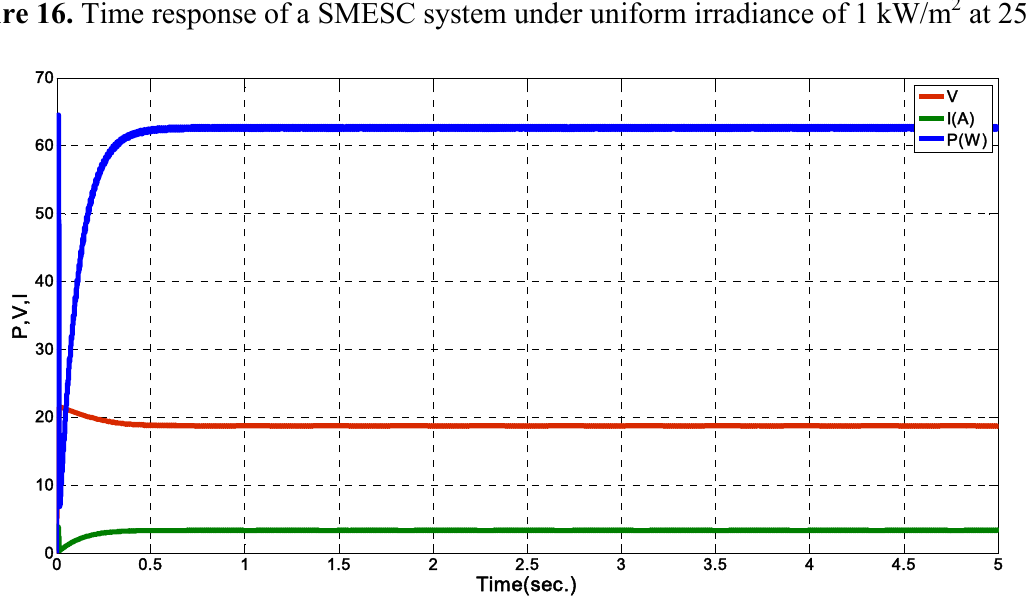
Figure 16. Time response of a SMESC system under uniform irradiance of 1 kW/m 2 at 25 °C.